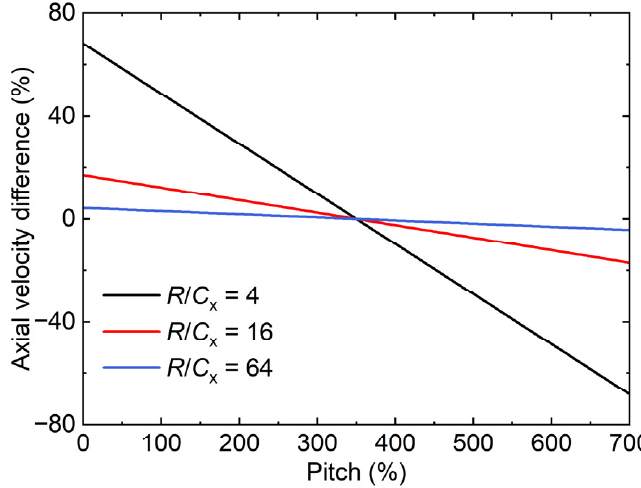
Figure 4. Schematic of axial velocity change with the pitch location.